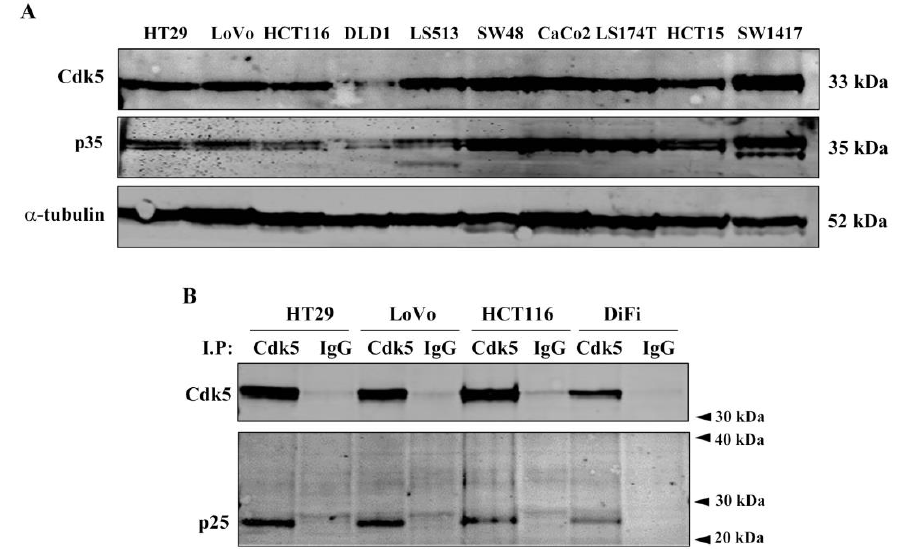
Figure 1. Cyclin dependent kinase 5 (Cdk5) and p35 (CDK5R1) expression in colorectal cancer (CRC) cell lines. ( A ) Western blot analysis of Cdk5 and p35 basal expression in a panel of 10 CRC cell lines. Alpha-tubulin was used as endogenous control. ( B ) Representative western blot images showing the co-immunoprecipitation of Cdk5 and p35 / p25 in the indicated cell lines. Co-immunoprecipitation with an immunoglobin G (IgG) antibody was used as a negative control. The results were obtained from at least three independent